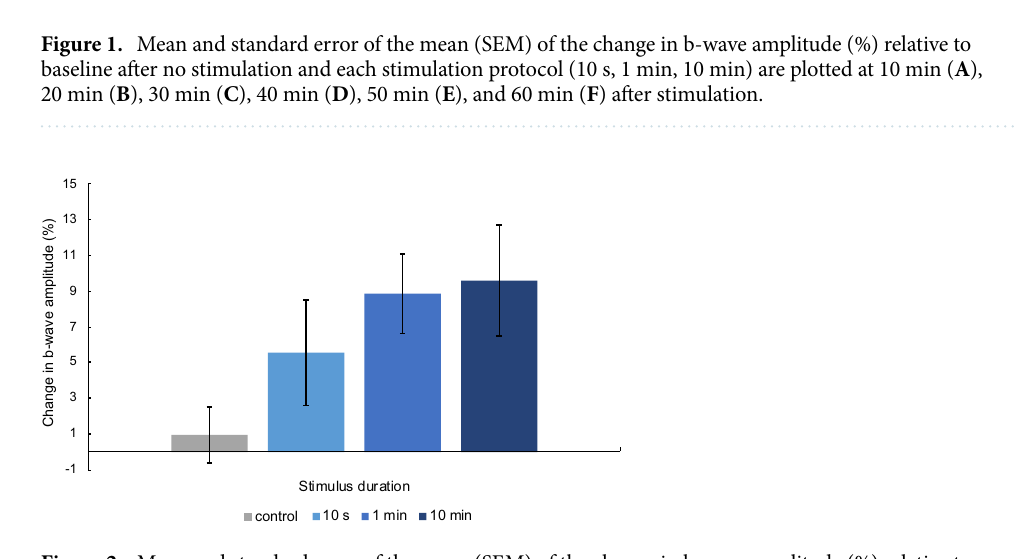
Figure 2. Mean and standard error of the mean (SEM) of the change in b-wave amplitude (%) relative to baseline after no stimulation and each stimulation protocol (10 s, 1 min, 10 min) averaged across measurements taken at 20, 30, 40, 50, and 60 min after